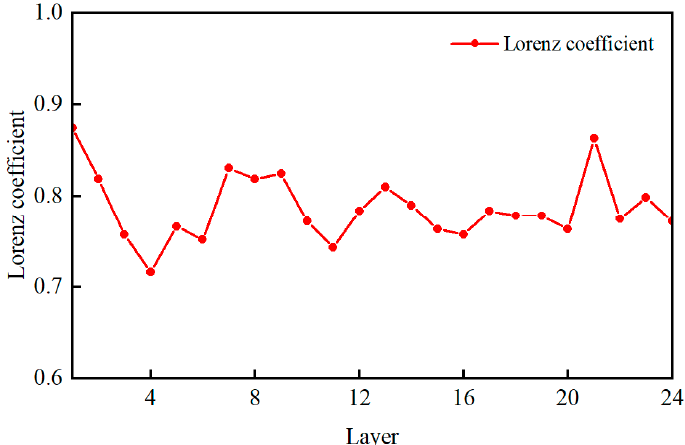
Figure 21. The Lorenz coefficients of each layer in an actual waterflooding reservoir.